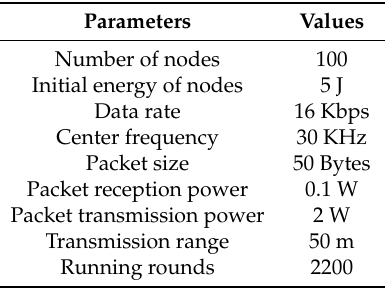
Table 1. Simulation